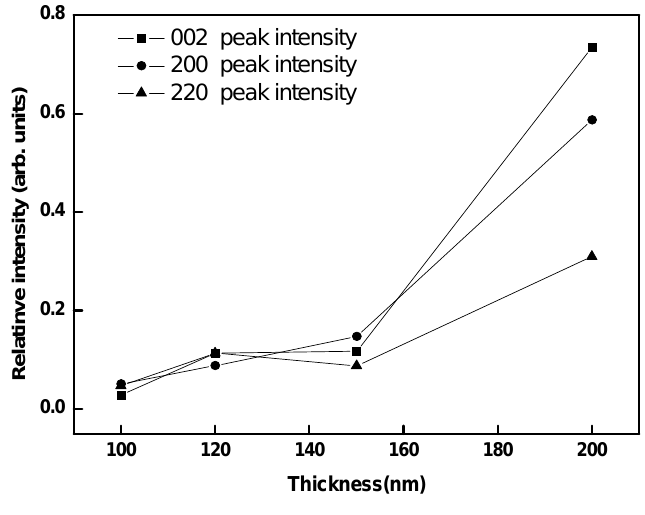
Figure 3. Variation of XRD peak intensities as a function of WO